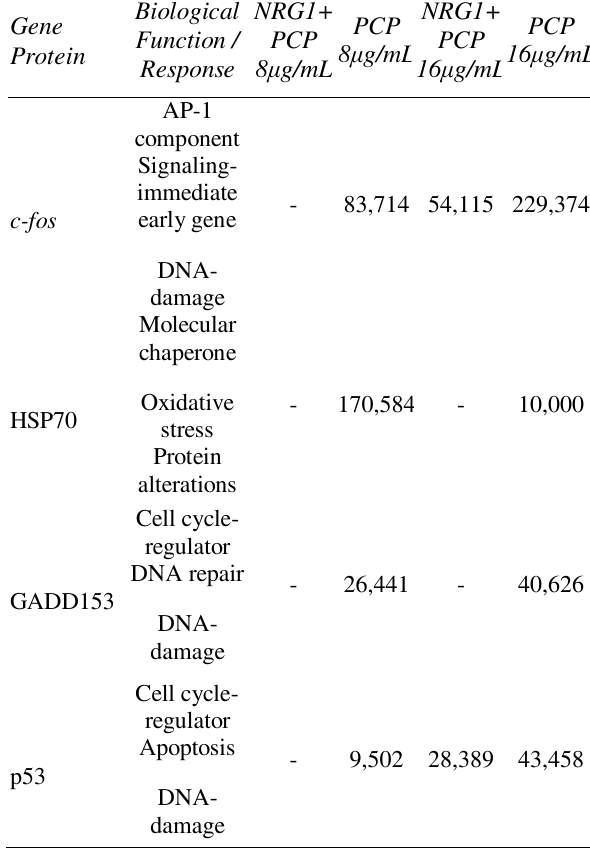
Relative abundance of significantly up- regulated proteins in AML 12 mouse hepatocytes exposed for 48 hrs to PCP in the absence or presence of NRG1- β (0.01